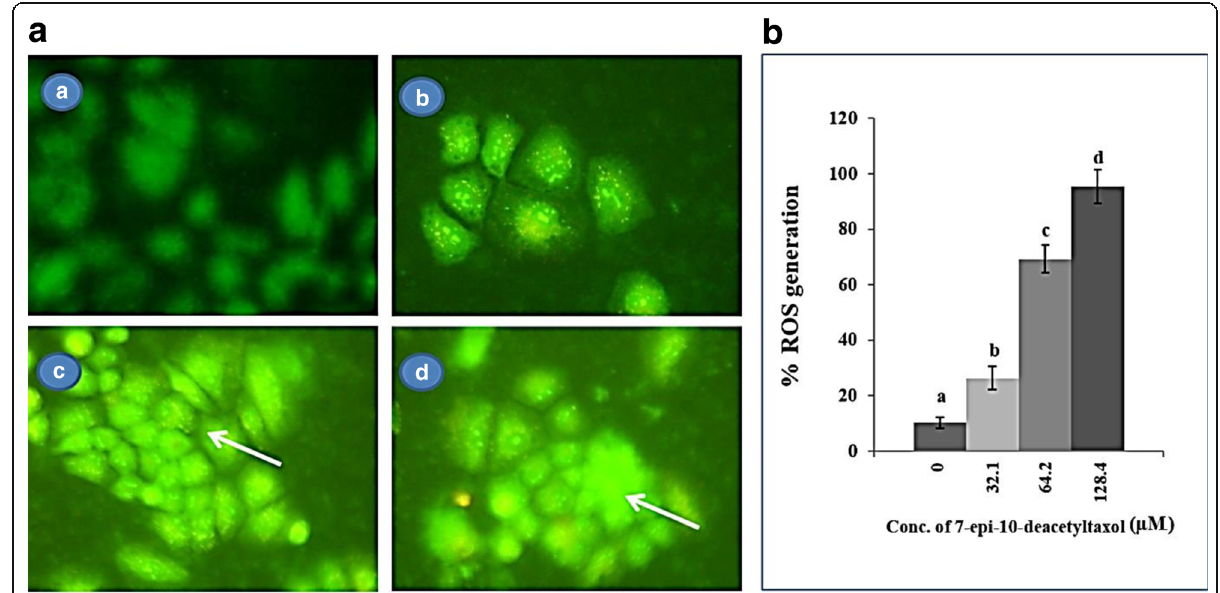
Fig. 11 Fungal EDT induced intracellular reactive oxygen species (ROS) in HepG2 Cells. Photomicrographs of ( a A ) Untreated cells and (a B-D ) HepG2 cells treated with 32.1 μ M, 64.2 μ M and 128.4 μ M, respectively of fungal EDT. Arrows are pointing high level accumulation of intracellular ROS as DCF fluorescence, ( b ) Quantitative analysis of intracellular ROS by spectrofluorometery. Data are expressed as mean ± SD from three independent experiments